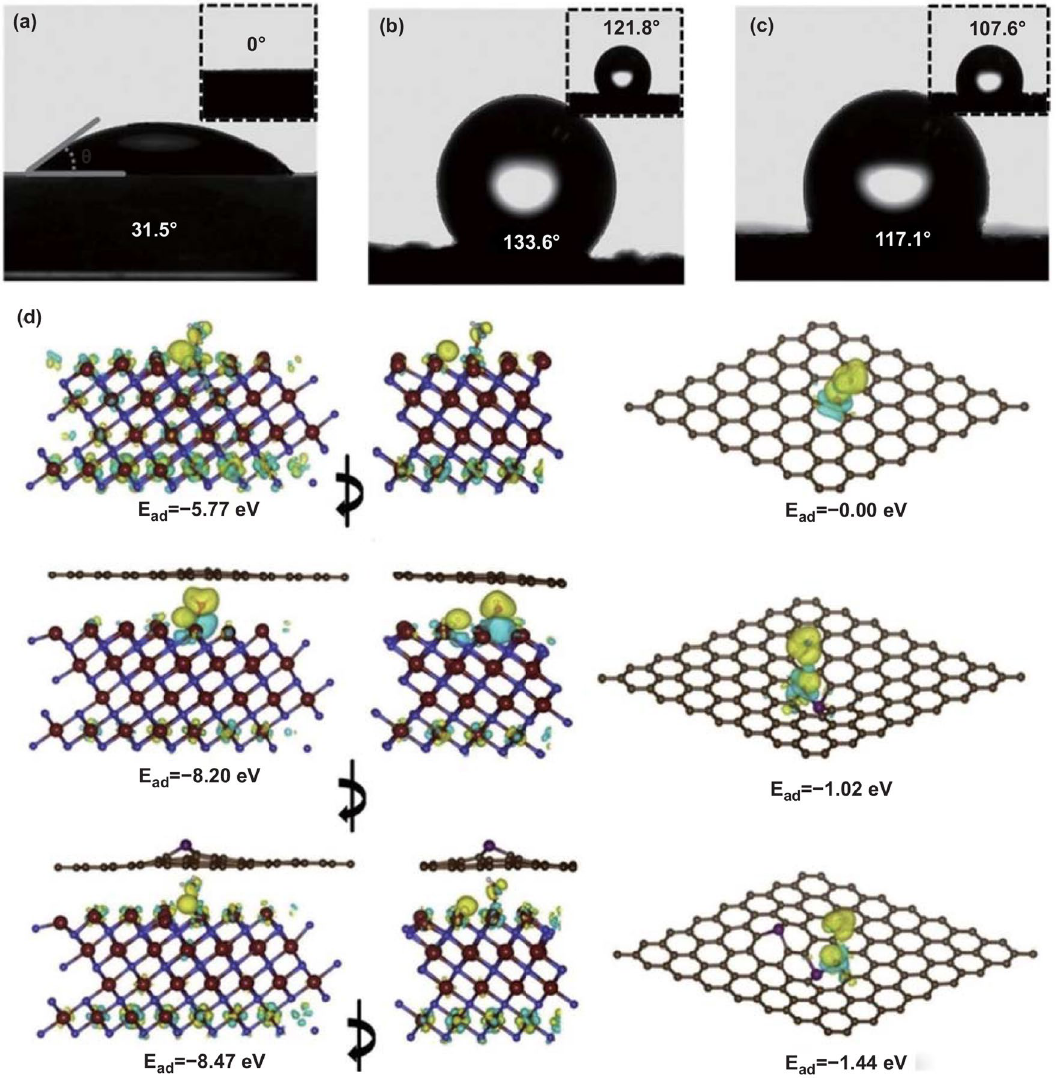
Fig. 7 a – c Comparison of water contact angles of N-carbon foam, carbon foam and carbon cloth. Adapted with permission from Ref [84]. Copyright 2016 Wiley–VCH. d DFT simulations of binding energy between MoN and P-doped carbon. Adapted with permission from Ref.